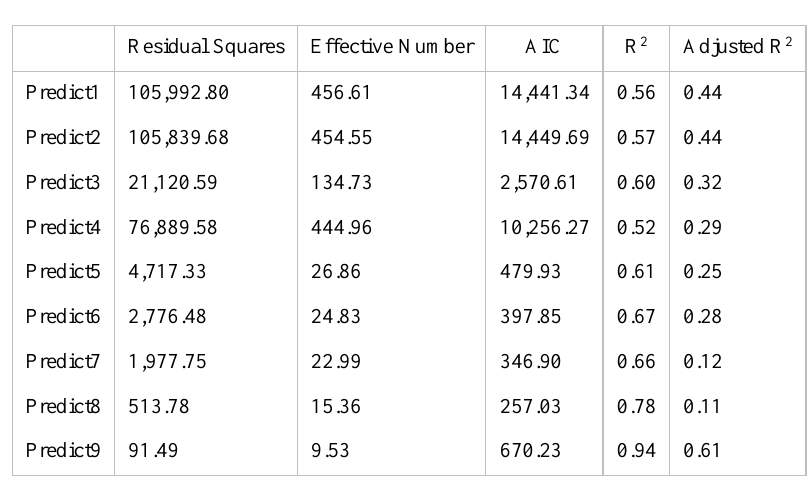
Table 2. Model Performance for Different Parameters in